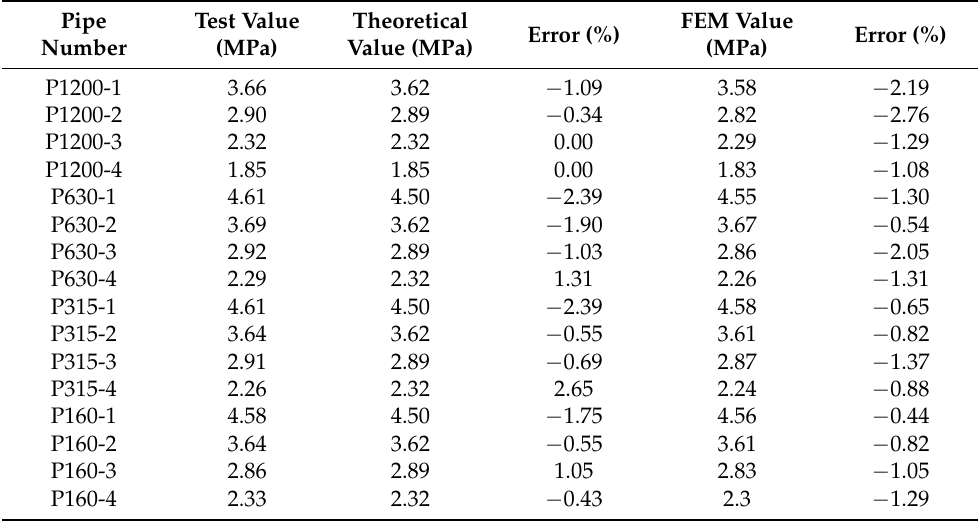
Table 3. Comparison of burst pressure